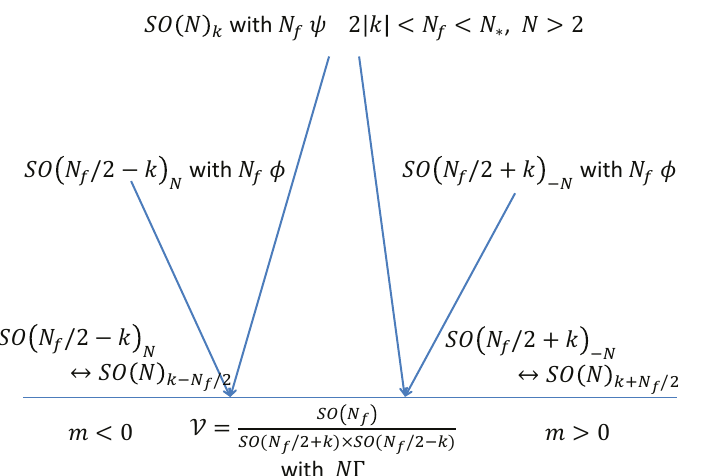
Figure 4 . The phase diagram of SO( N ) k for 2 j k j < N f